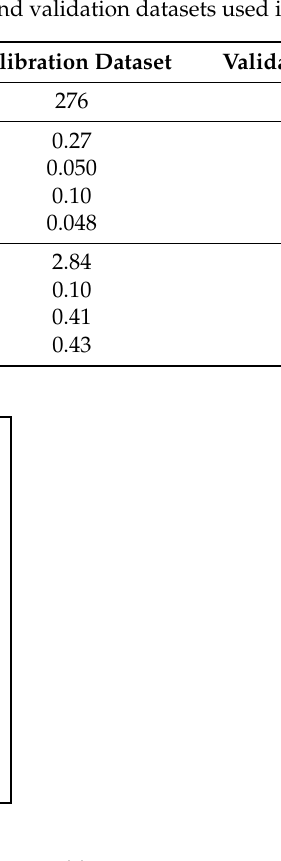
Figure 4. The distribution and correlation between each pair of four cation concentrations (g kg − 1 ) in soil samples. Note: ** marks a significant correlation at a level of p < 0.01.